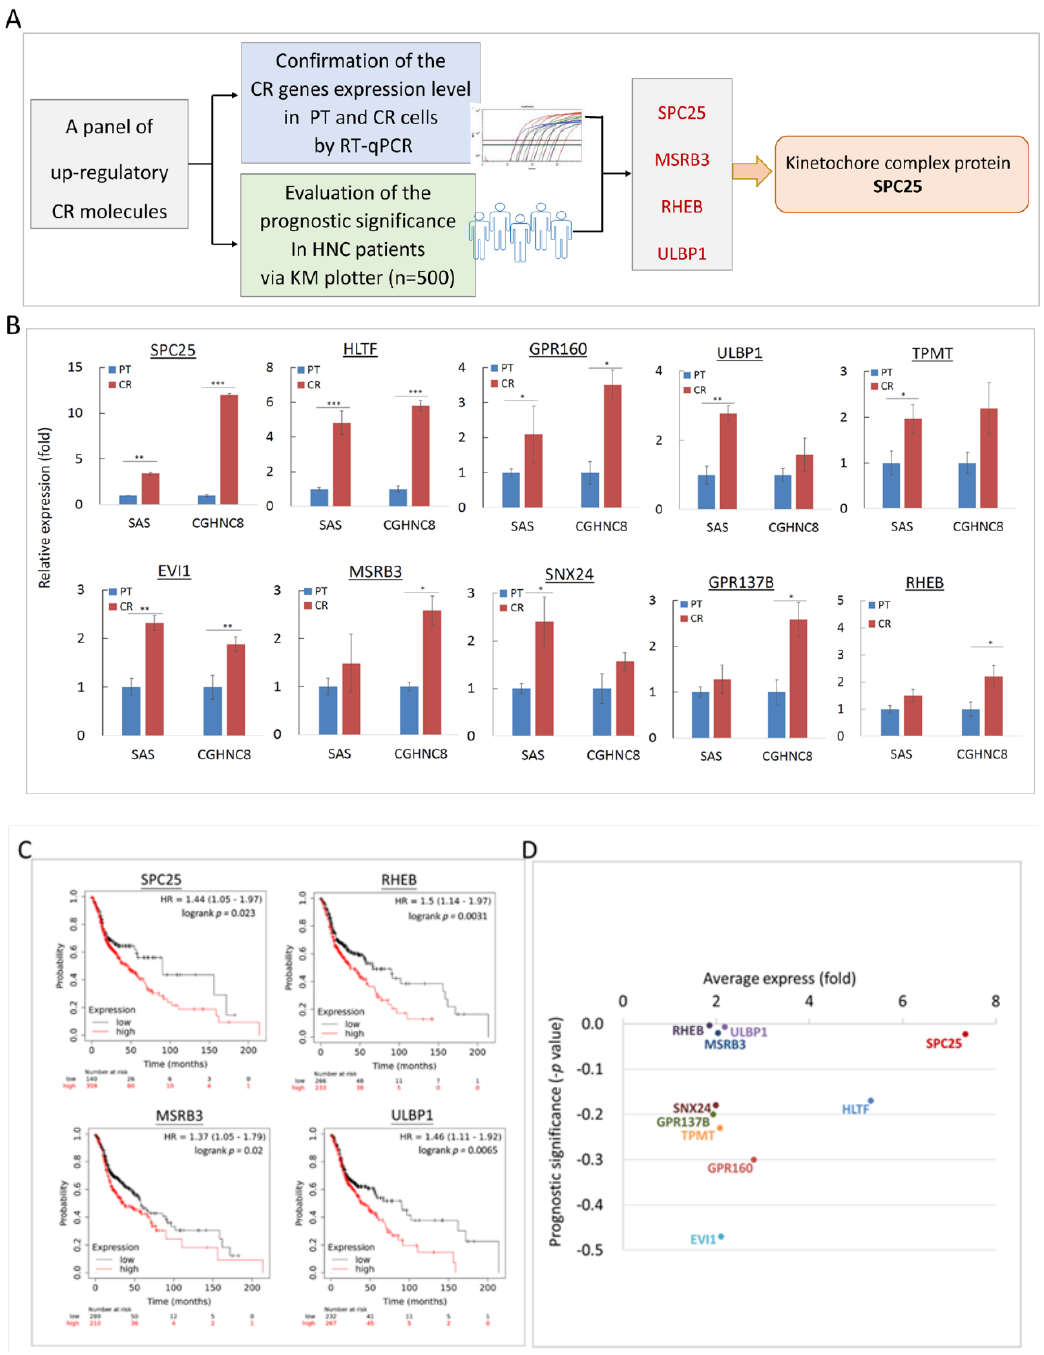
Figure 4. Prognostic significance of CR associated genes in HNC patients. ( A ) Flow diagram representing the enrichment process on HNC patients for survival analysis by KM-Plotter. ( B ) Relative expressions of 10 CR genes between parental (PT) cells and CR sublines of the SAS and CGHNC8 cell lines using the RT-qPCR method. The expression levels are shown by bars. ( C ) Prognostic significance determined by the Kaplan–Meier Plotter online tool using the head–neck squamous cell carcinoma dataset ( n = 500). ( D ) The overall view of 10 CR gene expressions ( x -axis) with the prognostic significance ( y -axis) for each gene. Values toward the top are signified higher levels of overexpression in CR cells, and those further to the right represent more clinical significance with poor prognosis (shown by the subtractive p -value) in HNC patients (*: p ≤ 0.05, **: p ≤ 0.01, ***: p ≤